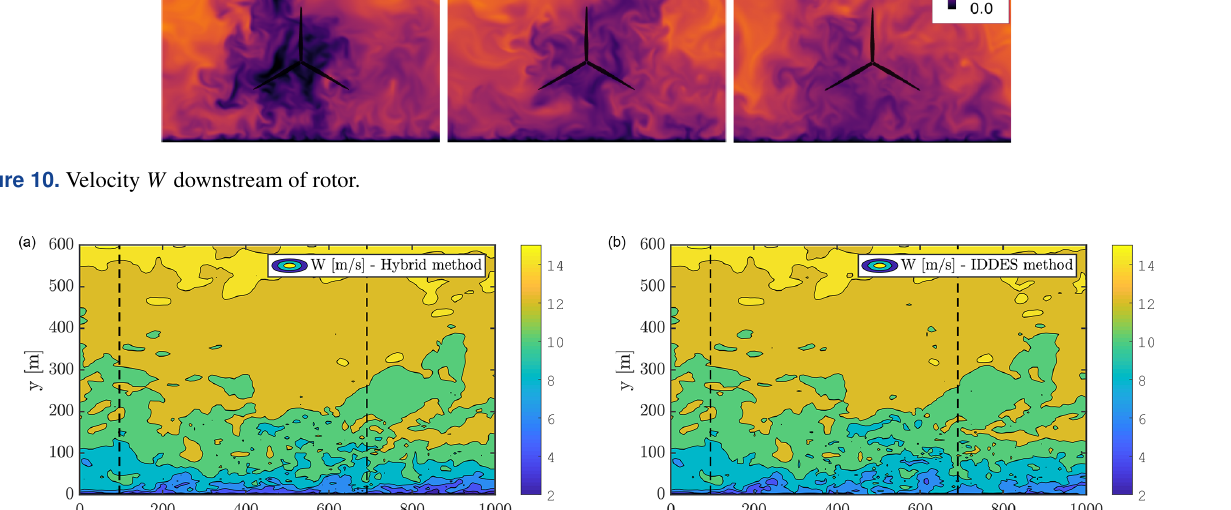
Figure 11. Instantaneous sections of flow velocity W for hybrid (a) and IDDES (b) simulations. Black dashed lines indicate the locations of the profiles presented in Fig.